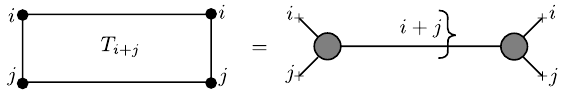
Figure 6. Diagrammatic representation for the replacement of the higher order Green’s function G i + j and the corresponding vertex functions in the Φ functional for the cluster virial expansion by the T i + j matrix for binary collisions in the channel with the partition i , j